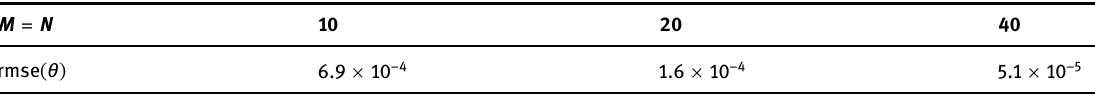
Table 2: The rmse error norm for ( ) θ t , for direct problem = M N 10